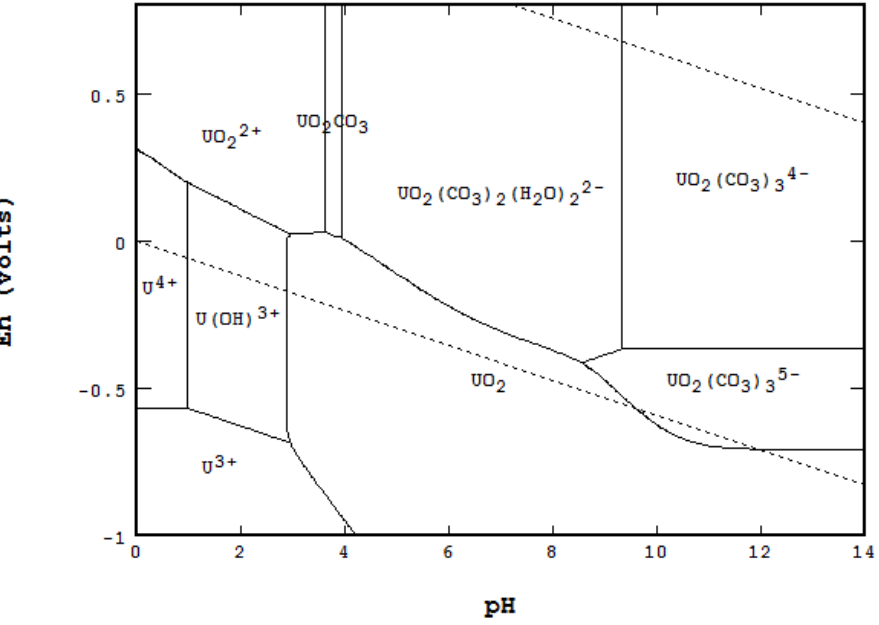
Figure 25. 3D diagram after Garrels and Christ. Label A is where the questionable species is located.